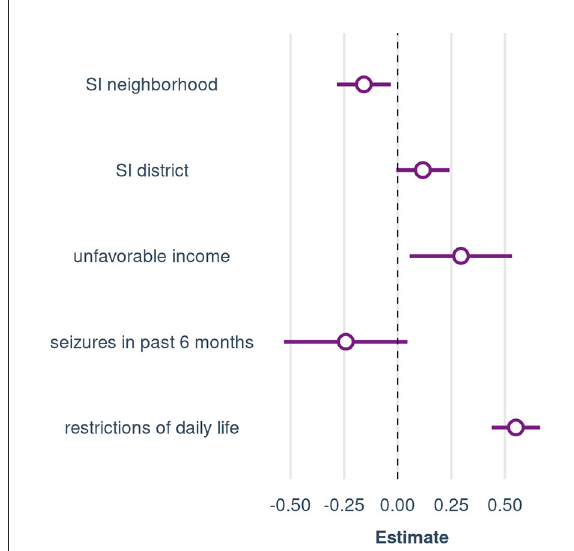
FIGURE3 Variables independently associated with perceived stigma in the multiple regression analysis. Presented are regression coefficients and the 95% confidence intervals of the model with continuous values of SI neighborhood and SI district (Model 1). Coefficients are standardized for the continuous predictors. SI, social index.